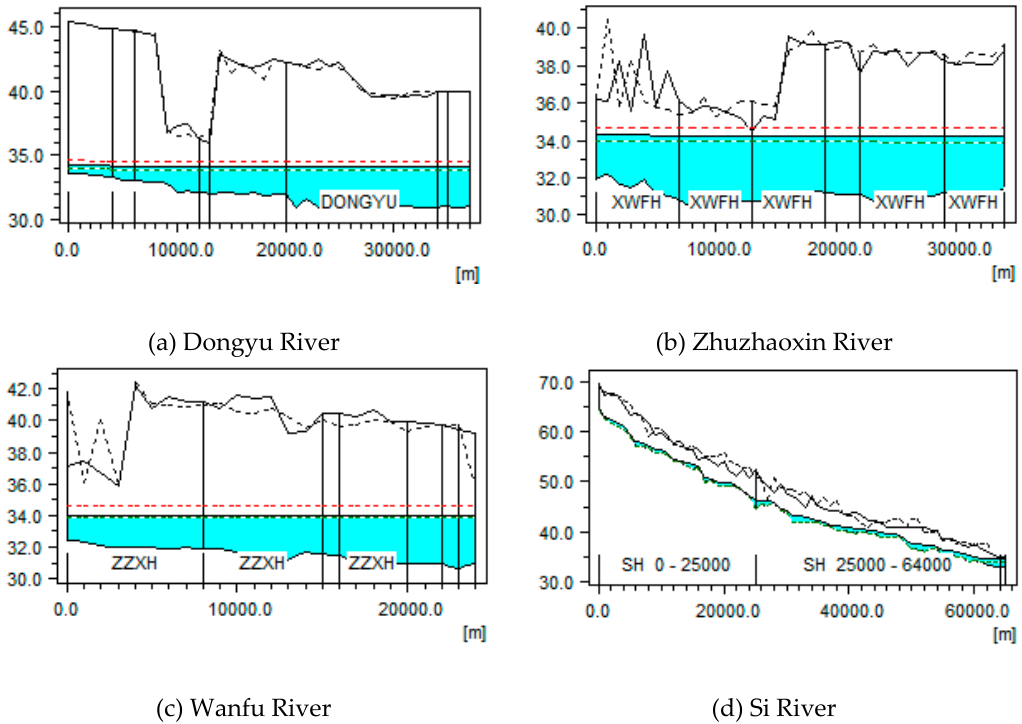
Figure 10. Instantaneous water levels of typical rivers.